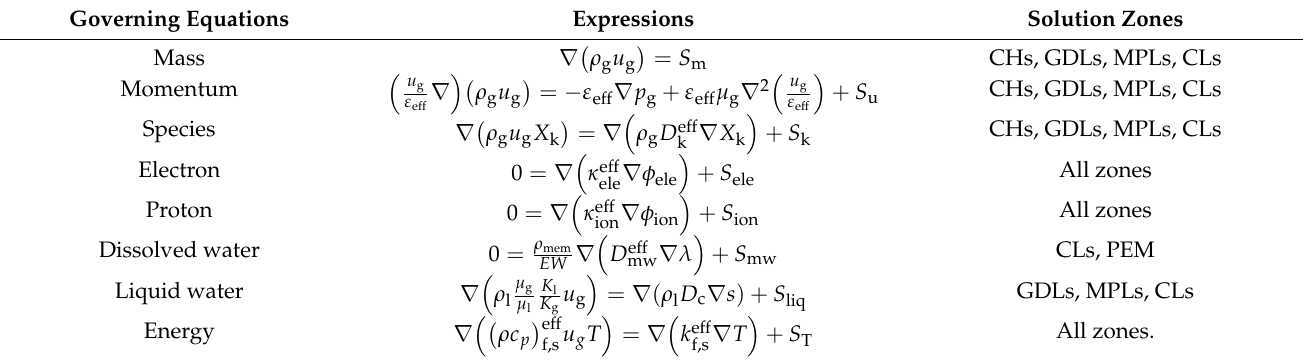
Table 2. Fuel cell Table 2. Fuel cell model.